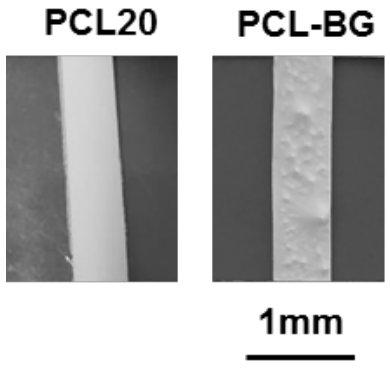
Figure 11. Digital images of electrospun fiber mats without (PCL20) and with BG particles (PCL-BG) before the mechanical testing.